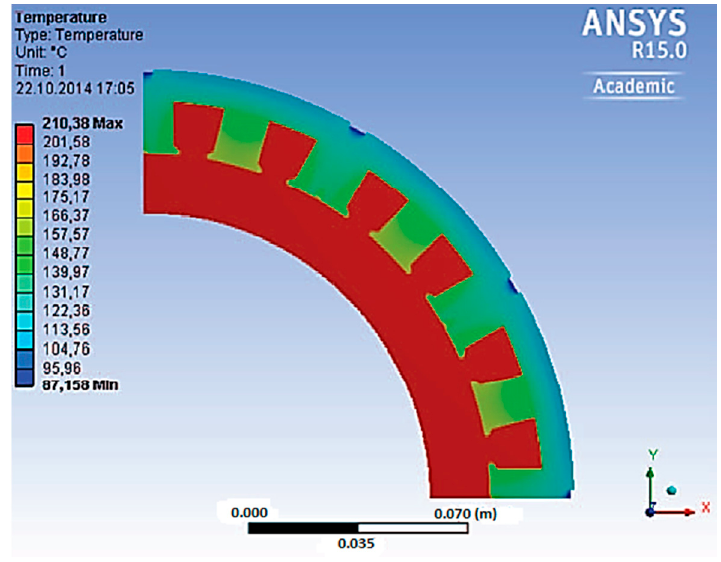
Figure 14. Temperature profile for a standard cooling jacket [60].